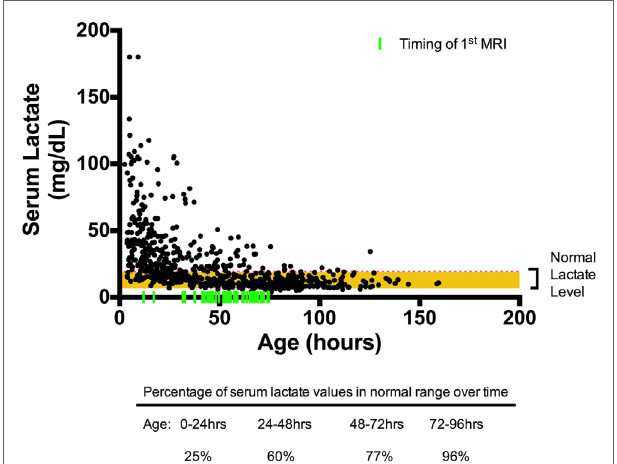
FigUre 1 | Scatter plot of serum lactate measured over time. All serum lactate values in black circles were plotted over time ( n = 780) with timing of first MRI indicated by fluorescent green vertical line. The red horizontal line marks the upper limit of normal serum lactate level (19 mg/dL). By 72–96 h of life, 96% percent of the serum lactate values are within reference